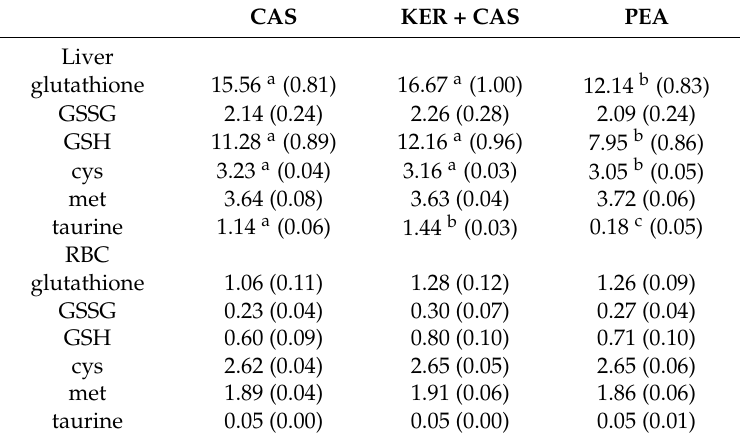
Table 6. Glutathione, GSSG (oxidised glutathione), and GSH (reduced glutathione) in µ mol/g tissue, in liver and peripheral blood RBC of rats fed for 4 weeks with test diets containing 18% w/w protein sourced from casein (CAS), 50:50 w/w keratin and casein (KER + CAS), or yellow pea flour (PEA) 1